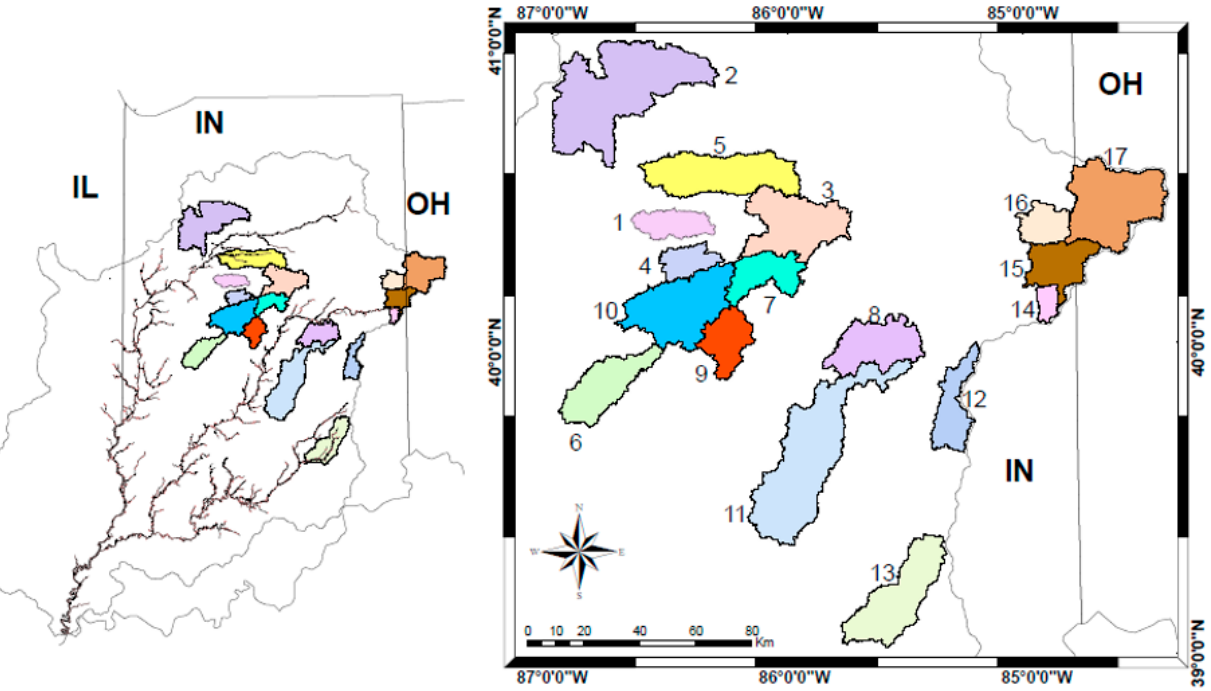
Figure 1. Sub-basins inside of Wabash River Watershed.